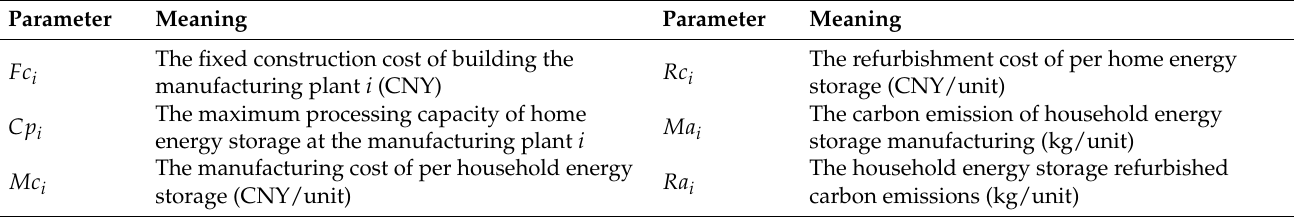
Table 2. Relevant parameters of the manufacturing plant.